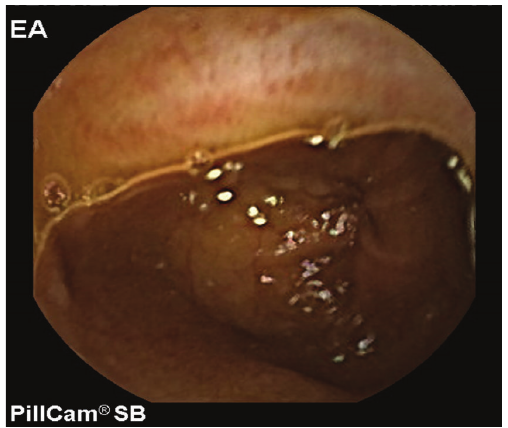
Figure 3: Wireless capsule endoscopy: yellow, round, and conceited area of the small